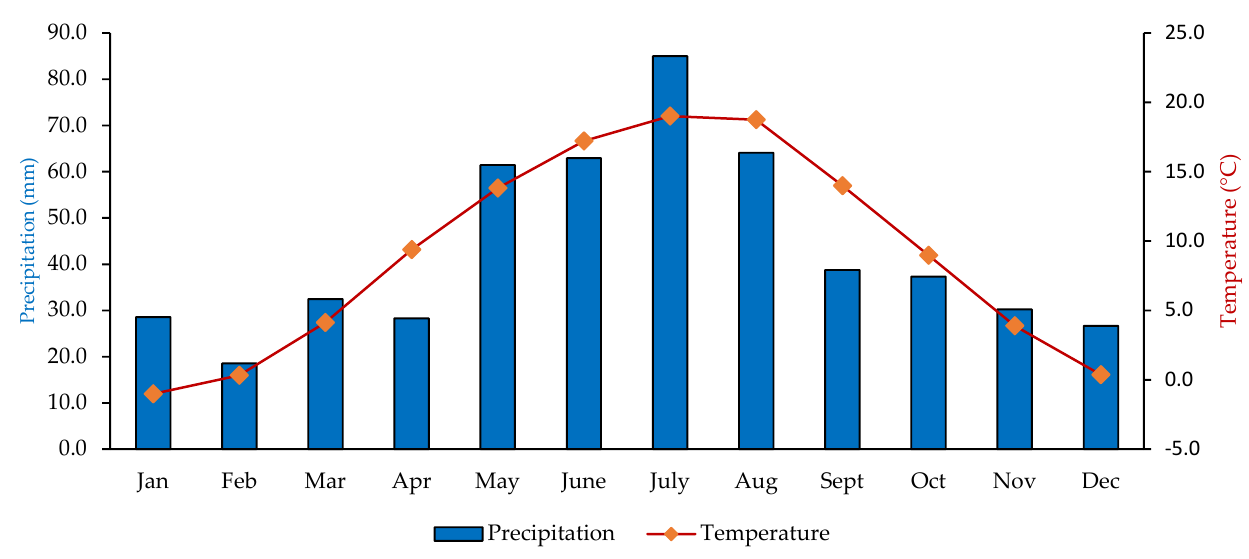
Figure 1. A climograph of average air temperatures and monthly precipitation calculated as average of 1997 to 2019 values. Table 1. Experimental site characteristics.